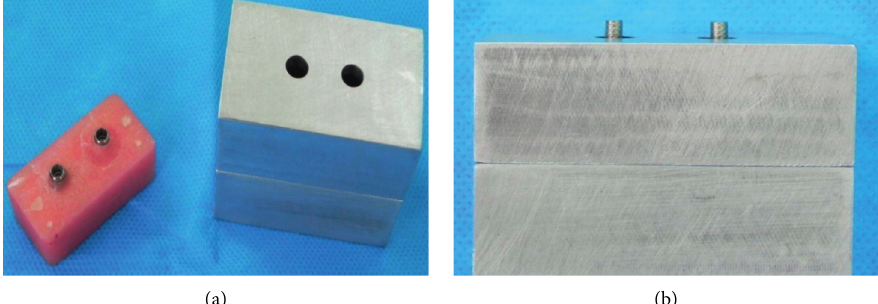
Figure 2: An aluminum index to unify the samples. (a) Aluminum index with two orifices with a diameter of 4.25mm and acrylic resin model and (b) remaining two millimeters of impression copings outside the index to access the screw-retained impression